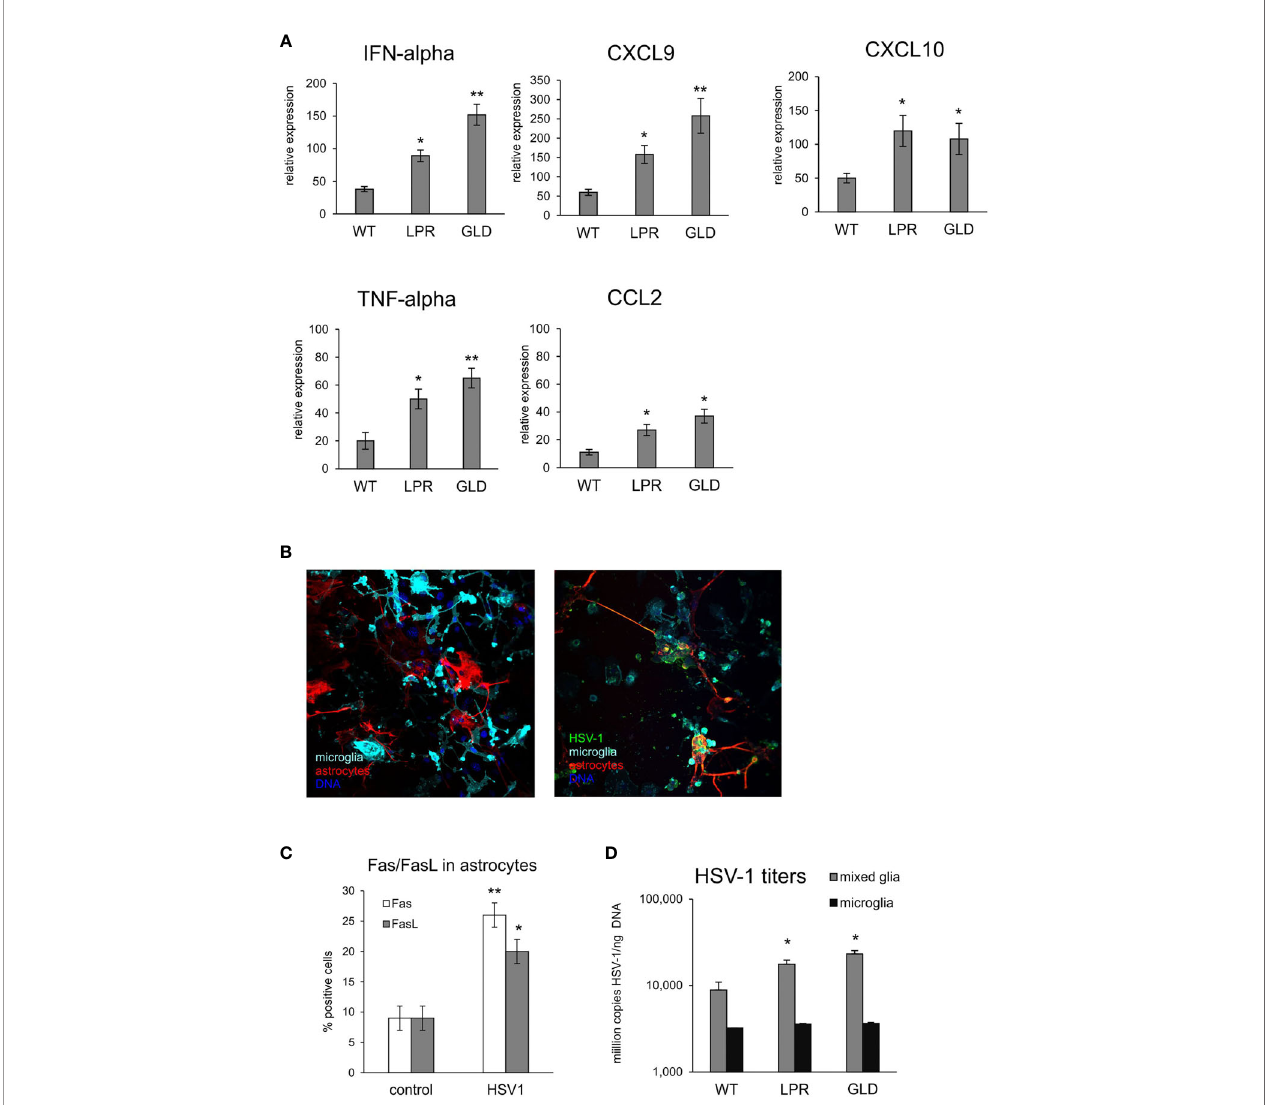
FIGURE 7 | Fas/FasL pathway is involved in microglia activation during HSV-1 infection in vitro . (A) Expression of IFN- a 4, CXCL9, CXCL10, TNF- a and CCL2 mRNA at 24 h p.i. in microglia cultures prepared from wild-type (C57BL/6), Fas-de fi cient (lpr) and FasL-de fi cient (gld) mice. Data were presented as mean ± SEM, N = 4. Data analysis was performed by comparing lpr and gld groups with wild-type mice. **p ≤ 0.001, *p ≤ 0.05. (B) Confocal microphotographs of uninfected (left) and HSV-1 infected (right) mixed glial cultures at 24 h p.i.; Co-immuno fl uorescent staining for HSV-1 antigens (green), GFAP+ astrocytes (red), IBA-1 positive microglia (red). Nuclei were counterstained with DAPI (blue). Magni fi cation x 200. (C) Fas and FasL expression measured by fl ow cytometry on uninfected and 24 h p.i. astrocytes from mixed glial cultures prepared from wild-type mice. Each bar represents the mean from 3 experiments (N = 3) ± S.E.M., *represents signi fi cant differences with p ≤ 0.05, while ** with p ≤ 0.01. (D) HSV-1 titers in DNA extracted from 24h infected wild-type mixed glia and puri fi ed microglia cultures using qPCR detecting gB gene. Each bar represents the mean from 4 experiments (N = 4) ± S.E.M., *represents signi fi cant differences with p ≤ 0.05, while ** with p ≤